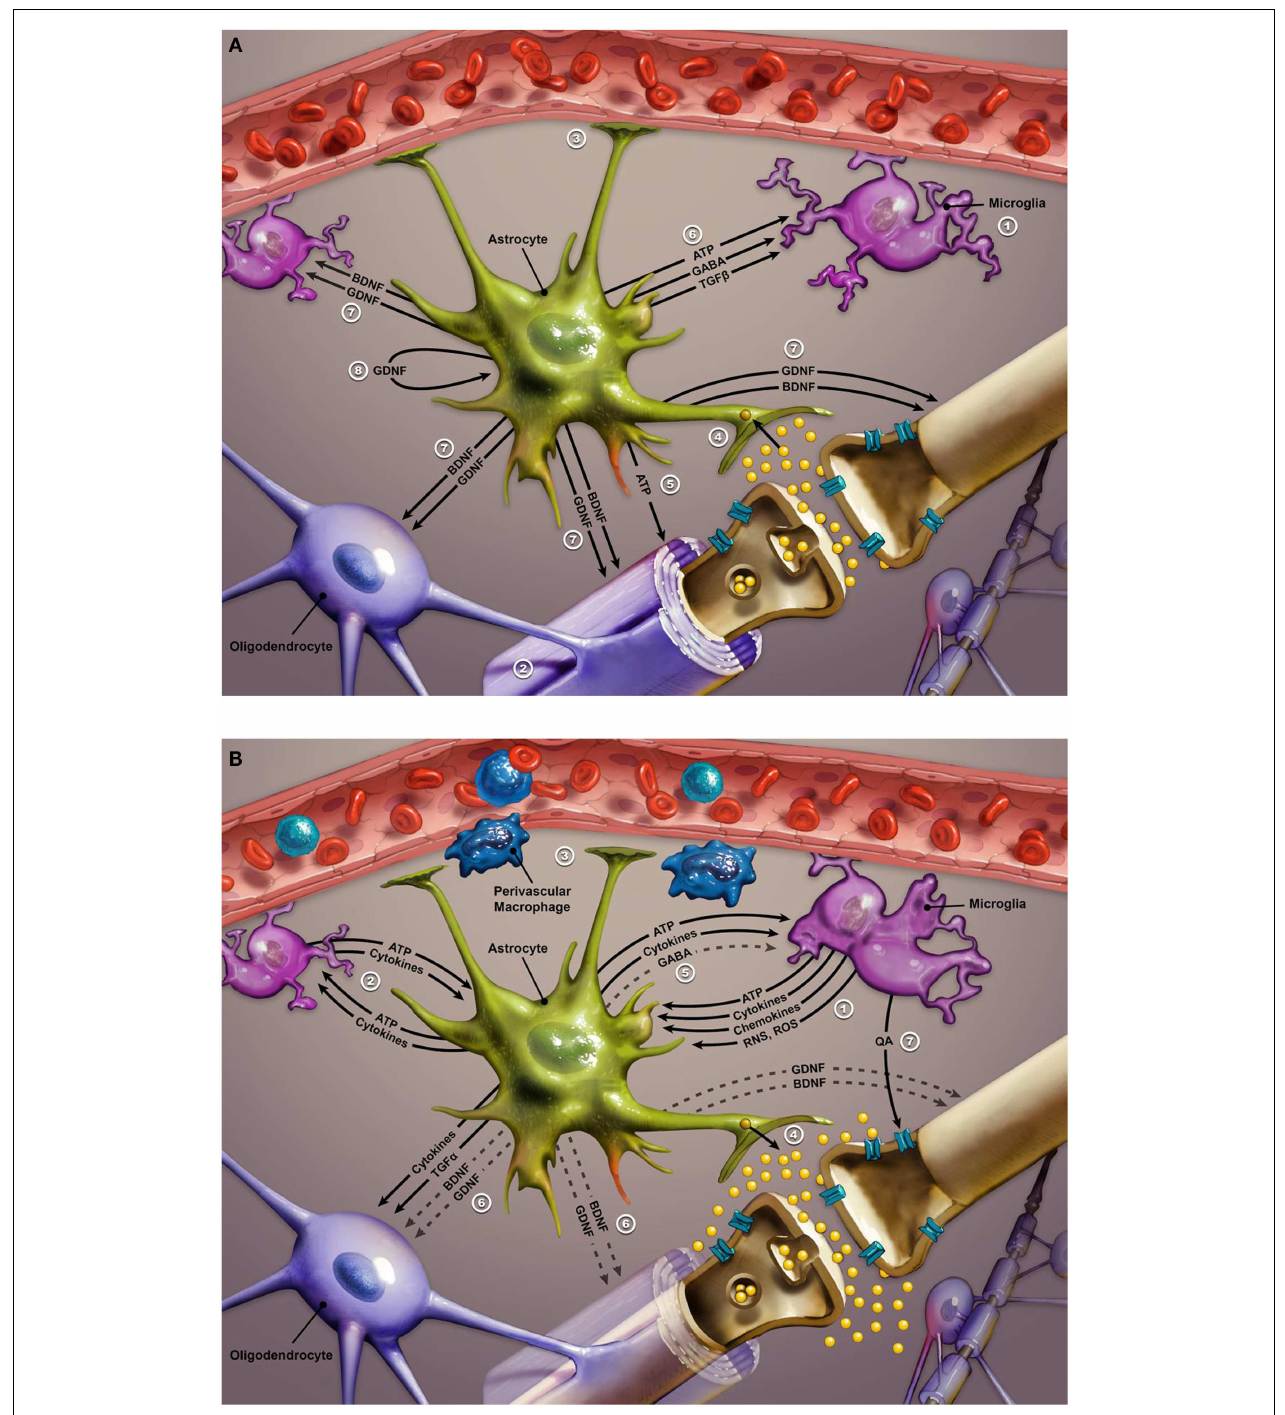
functions including: maintenance of the blood–brain barrier and facilitation of neurovascular coupling (3); protection of the neuronal synapse (4) by removing excess ions to keep firing rate steady and removing excess glutamate before it can diffuse out of the synapse to bind to extrasynaptic NMDA receptors (which are implicated in neurotoxicity); (5) release of ATP to reduce neuronal glutamate release; (6) calming and stabilizing microglia via release of ATP, GABA, andTGF β ; providing trophic support via BDNF and GDNF to neurons, microglia, and oligodendrocytes (7).